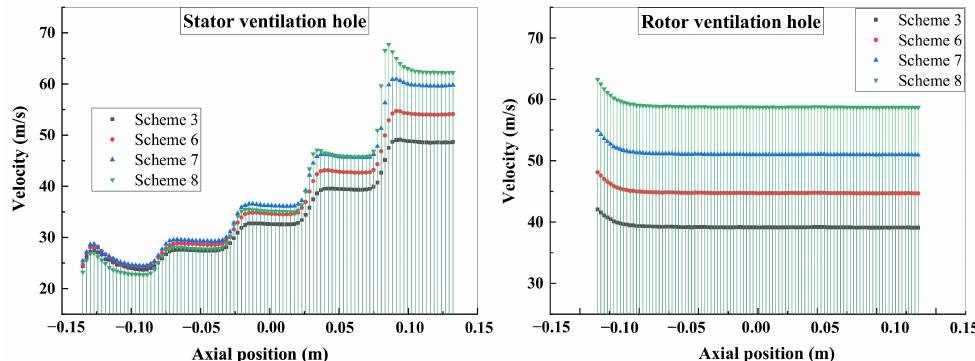
Figure 14. Velocity comparison under the scheme with varying cross-sectional diameter.